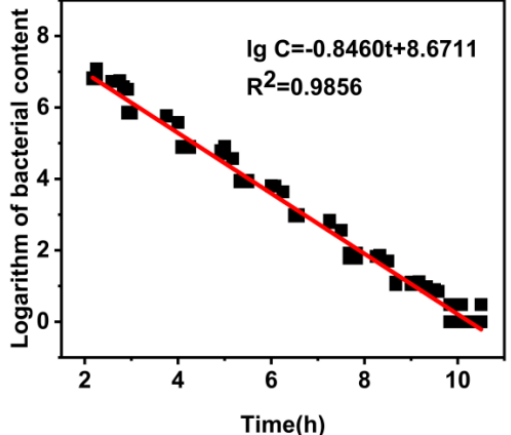
mulation; ( B ) indicates that the medium is capable of detecting E. coli without interference from other bacteria, even in the presence of bacteria; ( C ) shows that this medium is capable of detecting 1 CFU/mL of E. coli .